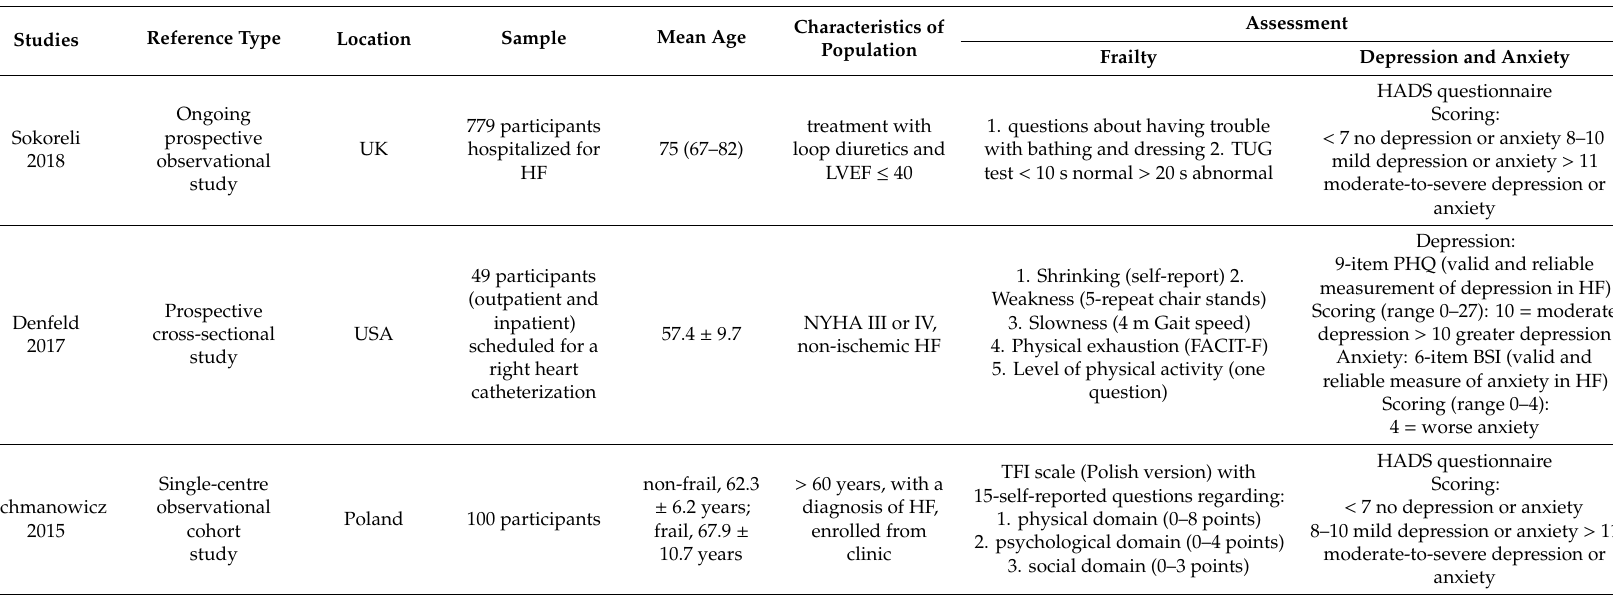
Table 1. Publications included in the